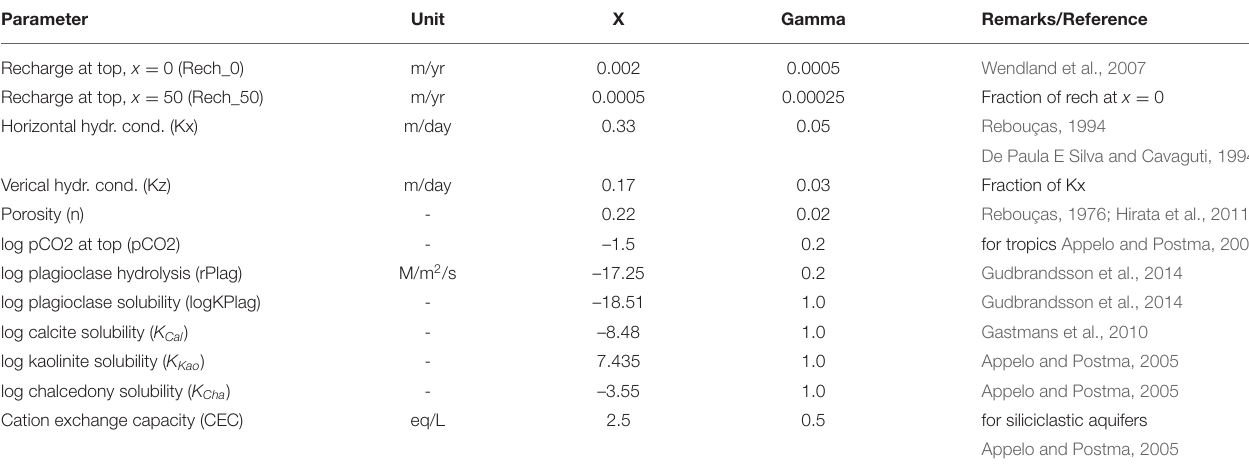
TABLE 1 | Parametrization of the reactive transport models with ranges explored in global sensitivity analysis. Parameter